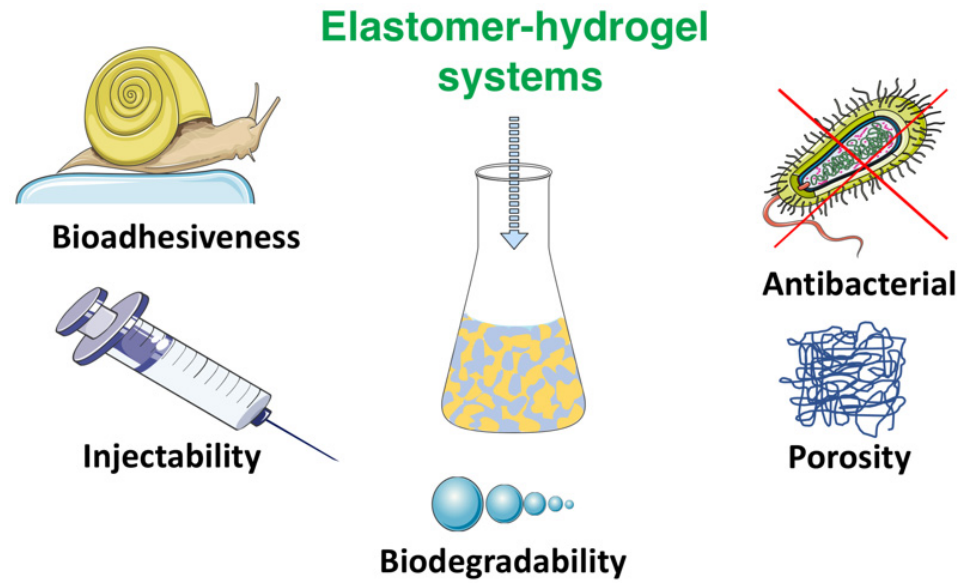
Figure 6. Functions and performance of elastomer–hydrogel systems.